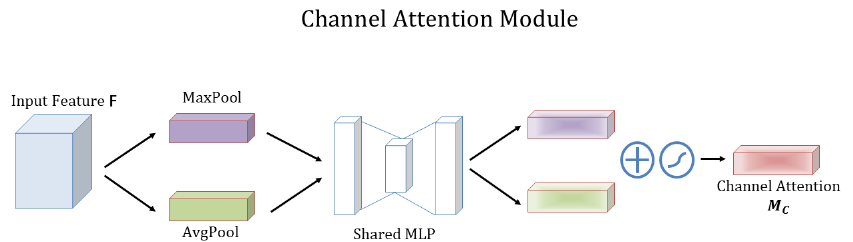
Figure 4. Illustration of channel attention module in